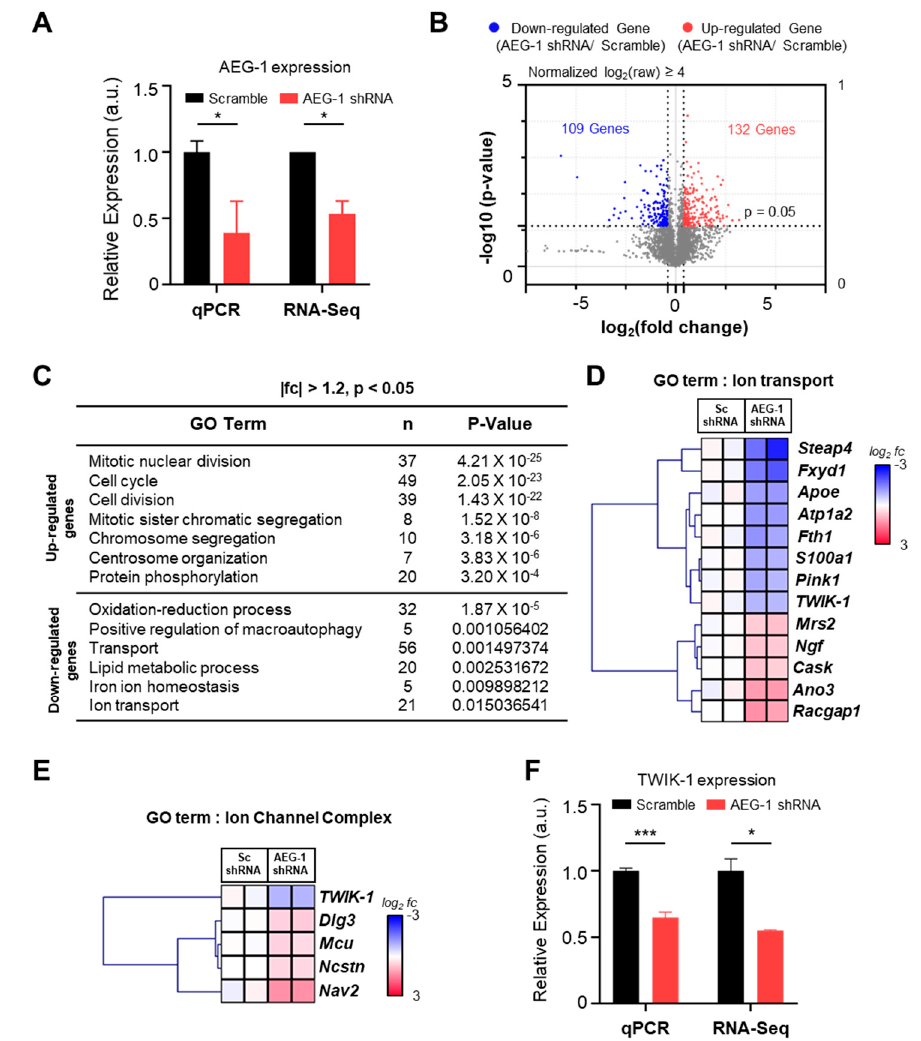
Figure 1. RNA-Seq and bioinformatic analysis of AEG-1 and its effect on TWIK-1 mRNA in cultured astrocytes. ( A ) Relative expression levels of AEG-1 mRNA in scramble (Sc) shRNA- and AEG-1 shRNA-transfected astrocytes. ( B ) Volcano plot of log 2 (fold change) for genes with values greater than 4 in scramble shRNA- and AEG-1 shRNA-transfected astrocytes. ( C ) GO Term analysis of differentially expressed genes. ( D ) Clustered heat map indicating the expression difference between genes in the ion transport GO category (red, up-regulated genes; blue, down-regulated genes). ( E ) Clustered heat map of genes in the ion channel complex GO category. ( F ) Relative expression levels of TWIK-1 mRNA in scramble (Sc) shRNA- and AEG-1 shRNA-transfected astrocytes. Data are presented as mean ± SEM. * p < 0.05, *** p < 0.001.